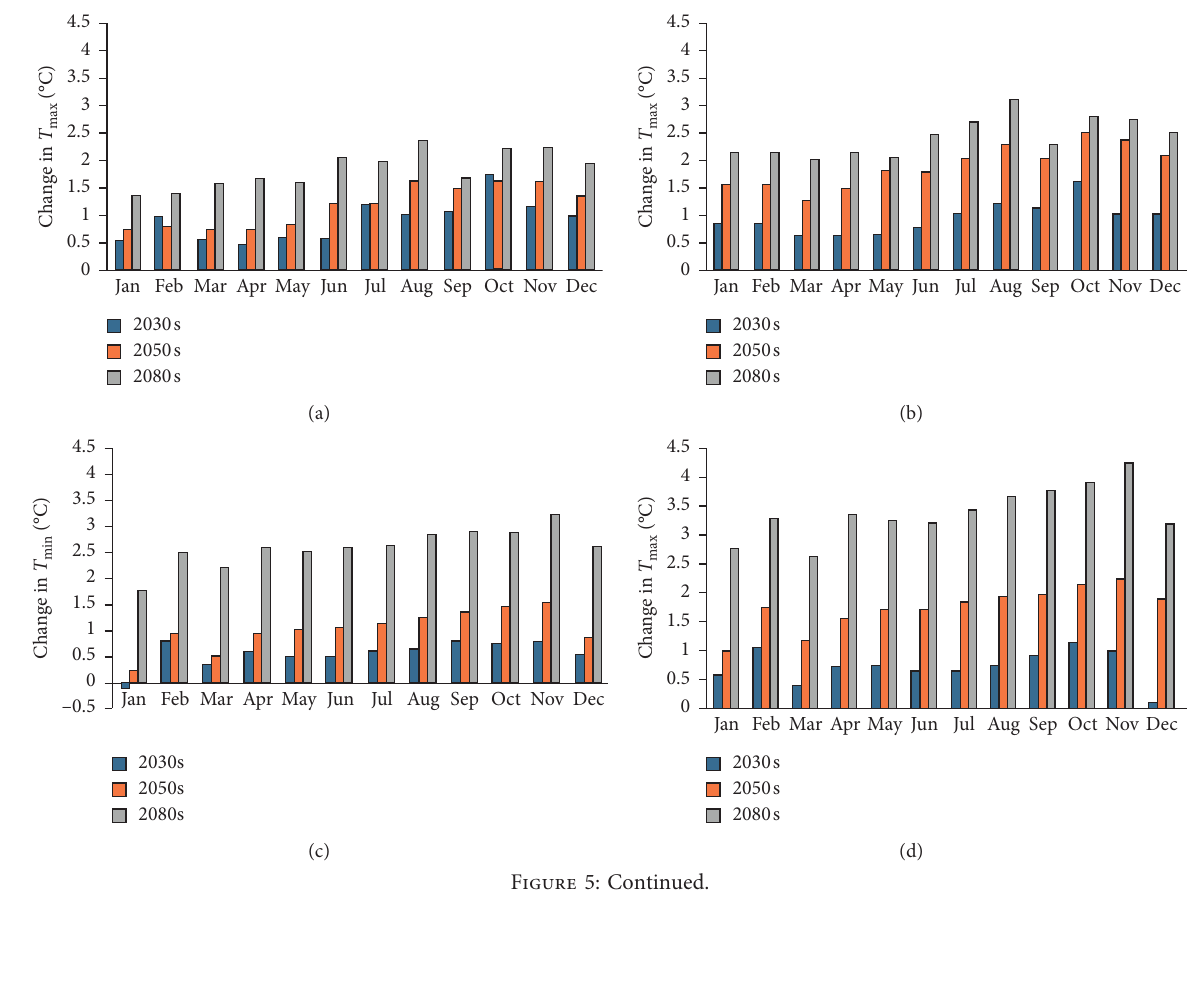
Figure 4: Temperatures and precipitation under RCP4.5 and RCP8.5. (a) For T under RCP4.5. (d) For T min under RCP8.5. (e) For P under RCP4.5. (f) For P under